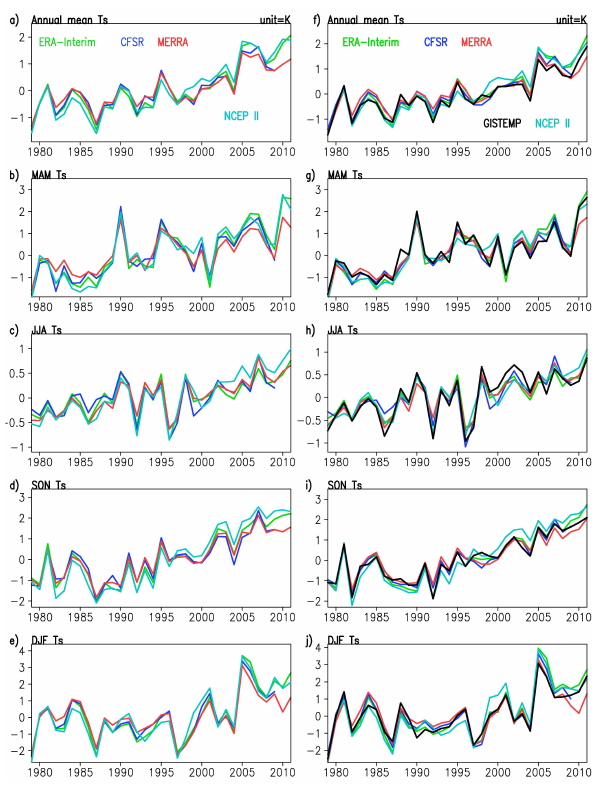
Fig. 2. 70–90 ◦ N average T s anomalies relative to 1979–2009 cli- matology from four reanalyses and GISTEMP. On the left, the true 70–90 ◦ N average is shown. On the right, the average is calculated using only those reanalysis data that correspond to the available GISTEMP data in location and time. Note that T s refers to surface air temperature (SAT) for the reanalyses, and to a combination of SAT over land and SST over ocean for